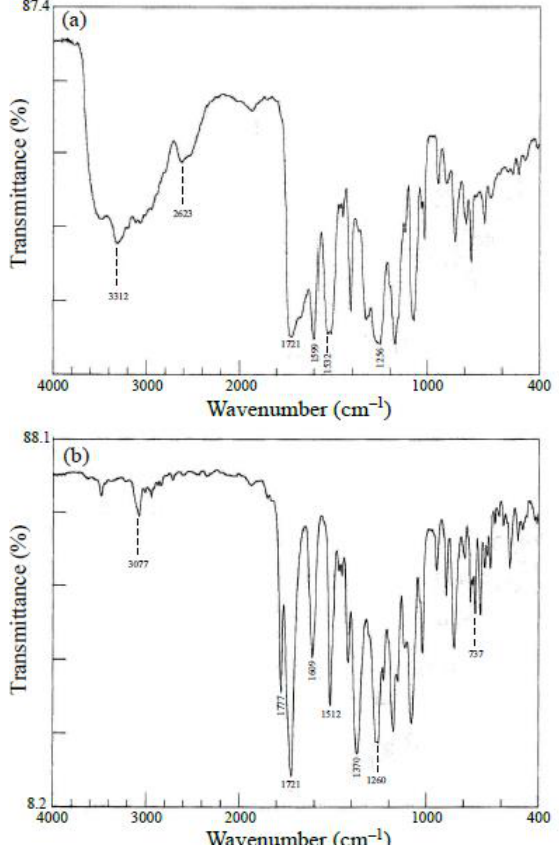
/ AB-MeOHQ system: ( a ) PAA and ( b ) Figure 5. FT-IR spectra of thin films for the s-BPDA/AB-MeOHQ system: ( a ) PAA and ( b ) PEsI. Figure 5. FT-IR spectra of thin films for the s-BPDA